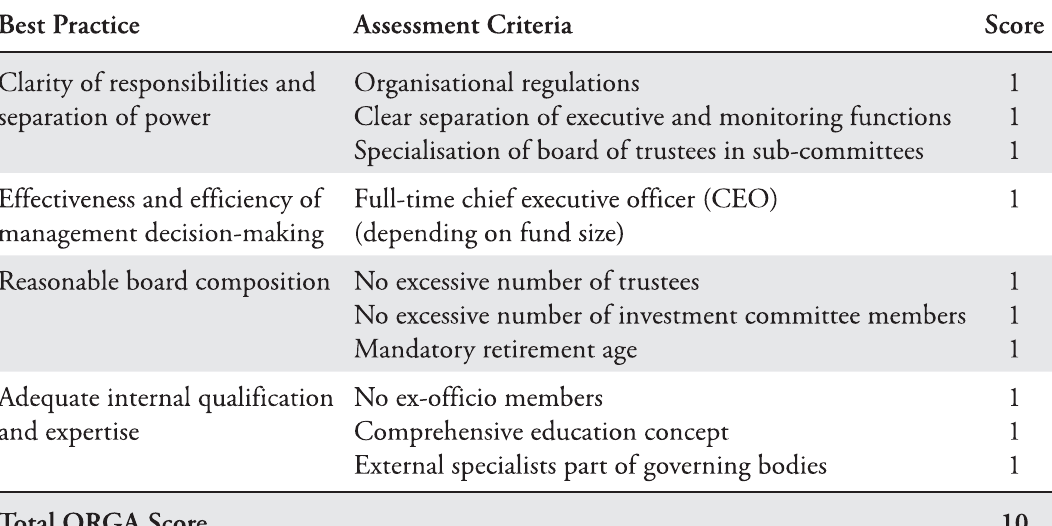
Table 1: Composition of the ORGA Score